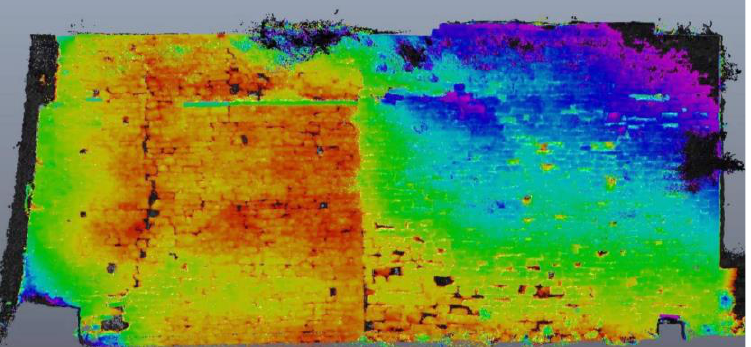
Figure 10. Out-of-plane deformations of the northern elevation of the tower obtained through processing the LIDAR point cloud. The spectrum colour scale indicates the distance of each point to a reference plane, having red colours indicate areas farther away from the plane and purple areas being the closer ones.